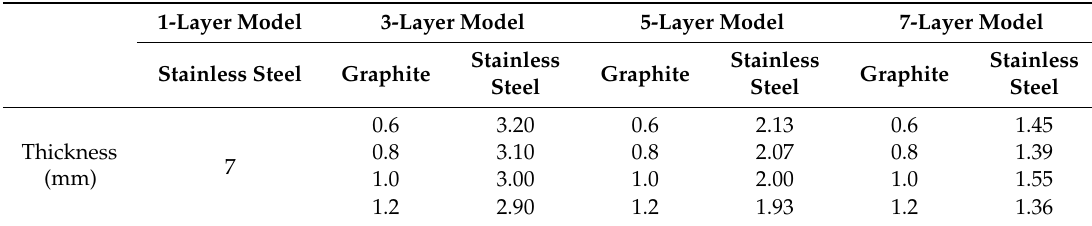
Table 2. Thicknesses of graphite and stainless steel according to the number of layers.